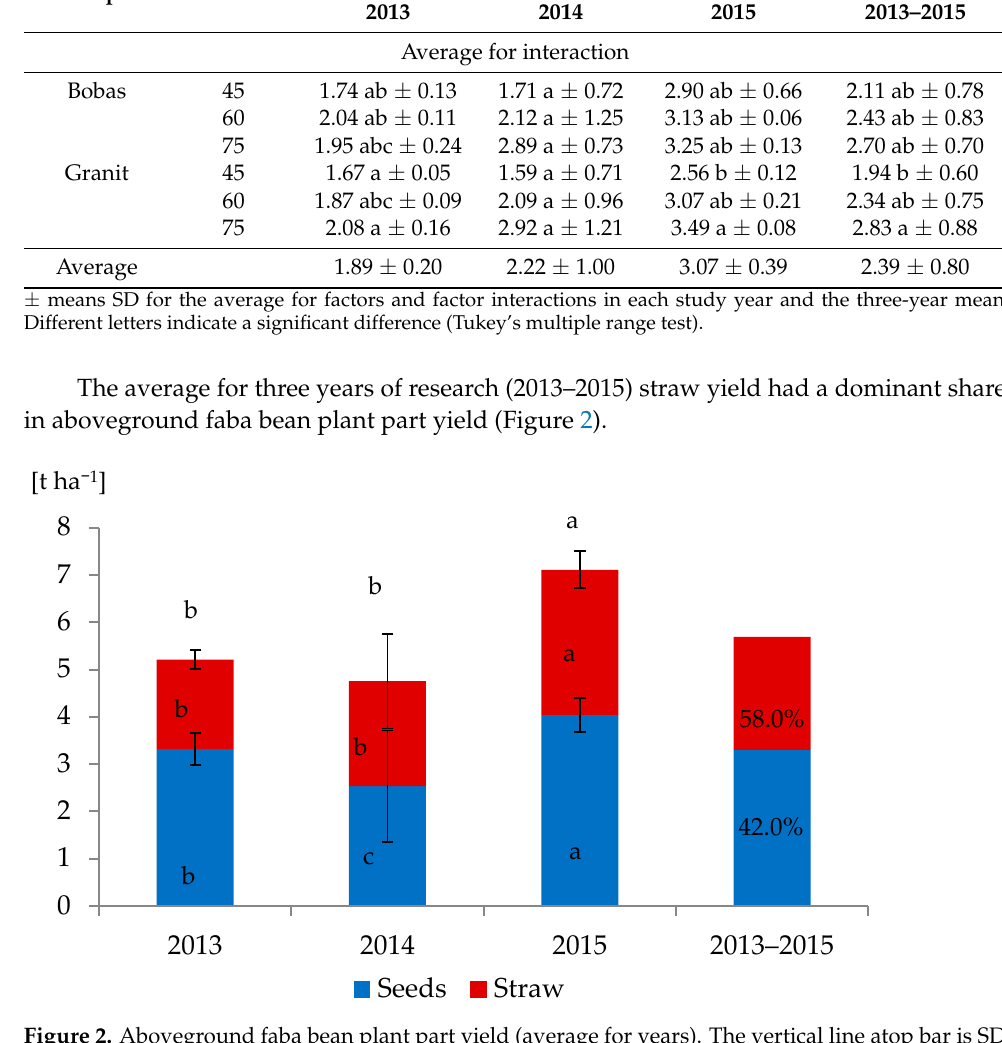
Figure 2. Aboveground faba bean plant part yield (average for years). The vertical line atop bar is SD for that mean. Different letters indicate a significant difference (Tukey’s multiple range test).